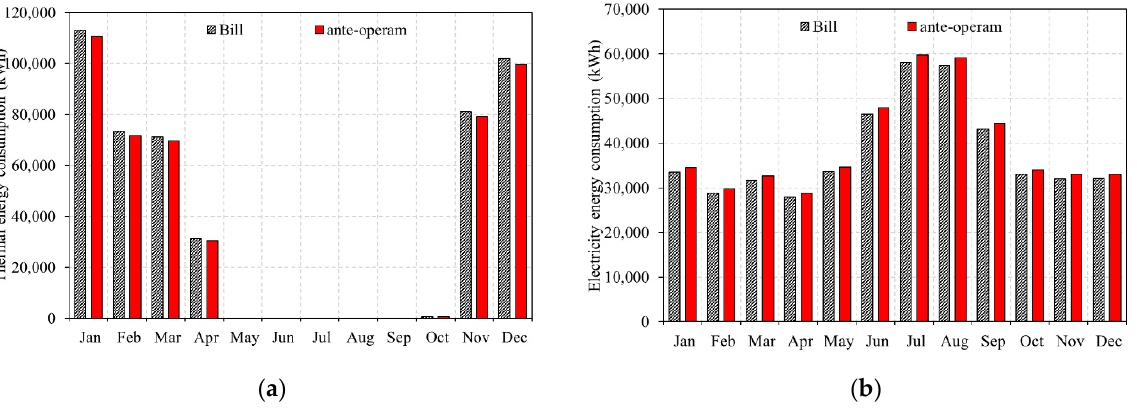
Figure 4. Comparison between the bill readings and the simulated energy consumption of ( a ) thermal and ( b ) electricity.